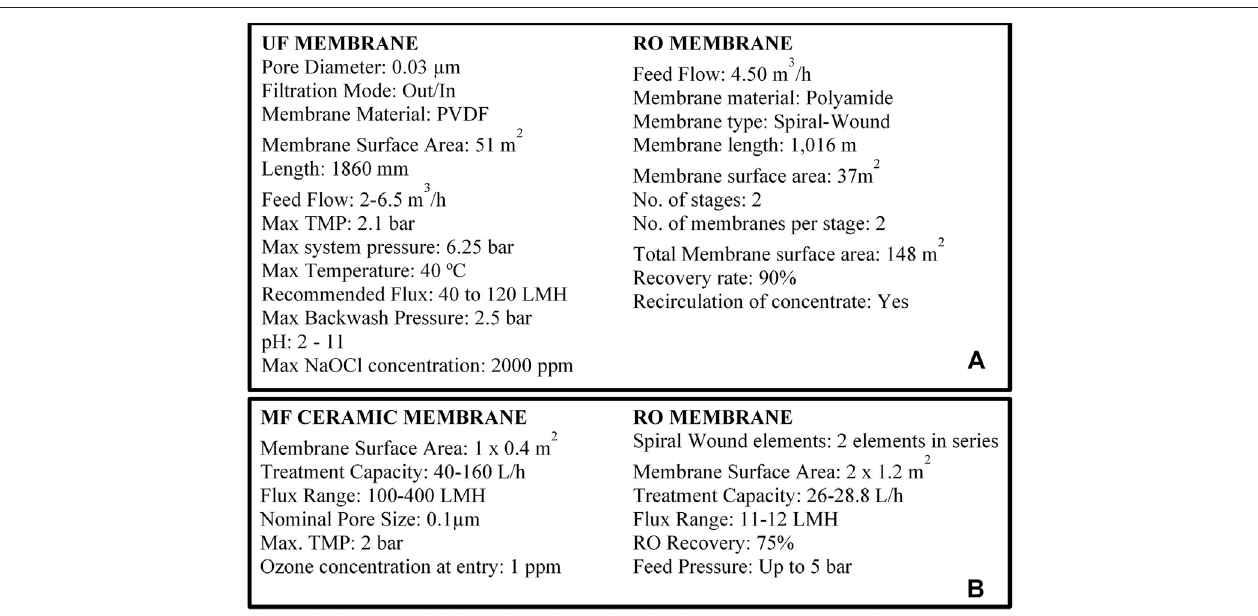
FIGURE 1 | Membrane characteristics of the two treatment trains, (A) UF + RO, (B) Ozone + Coagulation + MF + RO.